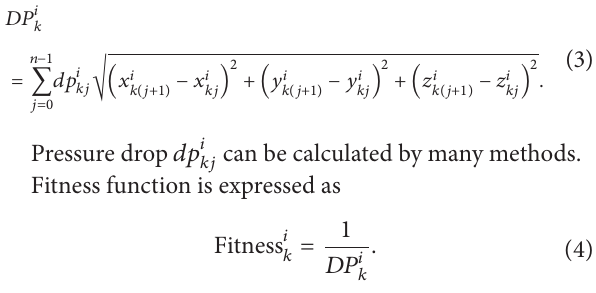
Figure 3: The block diagram of genetic